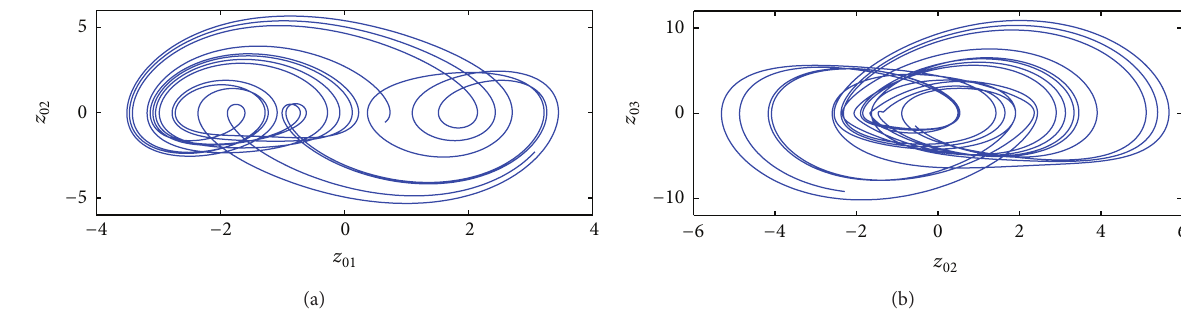
Figure 1: The chaotic attractor of system (19) for 𝑞 𝑑0 = 0.995